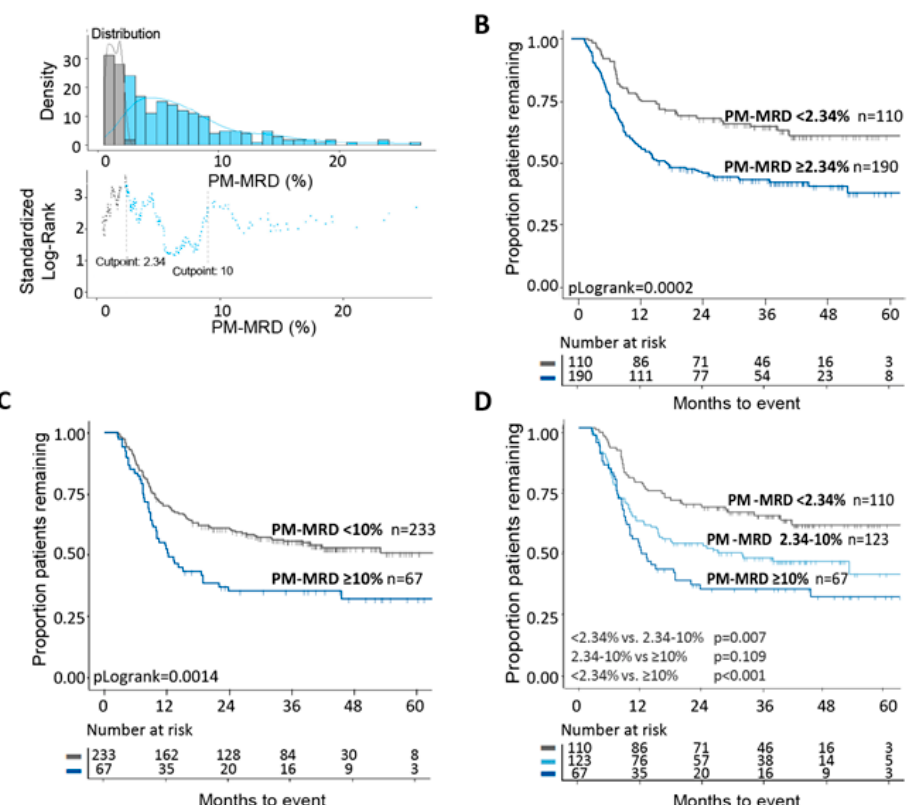
Figure 2. Prognostic impacts of different PM-MRD cut-off values. ( A ) Using the standard Log-Rank analysis, the optimal cut-off values of 2.34% and 10.0% were determined (X-axis denotes % PM-MRD). ( B ) Using the cut-off value of 2.34% allowed the discrimination of two patients groups with different EFS: 42.6% for PM-MRD positive and 63.6% for PM-MRD negative . ( C ) For the 10.0% cut-off value, EFS was 34.3% for PM-MRD positive and 54.9% for PM-MRD negative . ( D ) When the two were